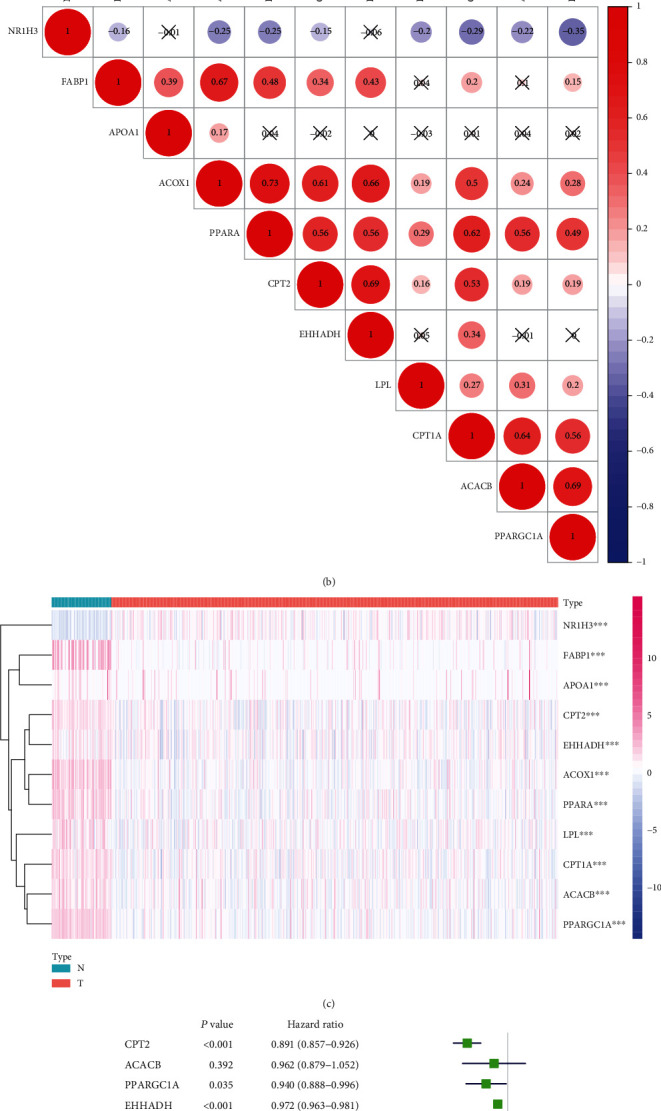
Coexpression analysis of CPT1A and ten associated genes along with the gene expression and hazard ratio analysis in KIRC. (a) PPI network diagram between CPT1A and the ten most relevant genes. (b) Schematic diagram of the coexpression of these eleven genes. (c) Heat map demonstrating the expression of the eleven genes in KIRC. The higher the intensity of red color, the higher is the expression. The higher the intensity of blue color, the lower is the expression. (d) Hazard ratio analysis of the 11 genes in KIRC. ∗∗∗P < 0.001.